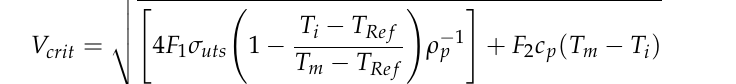
ing EDS ing EDS spectra.